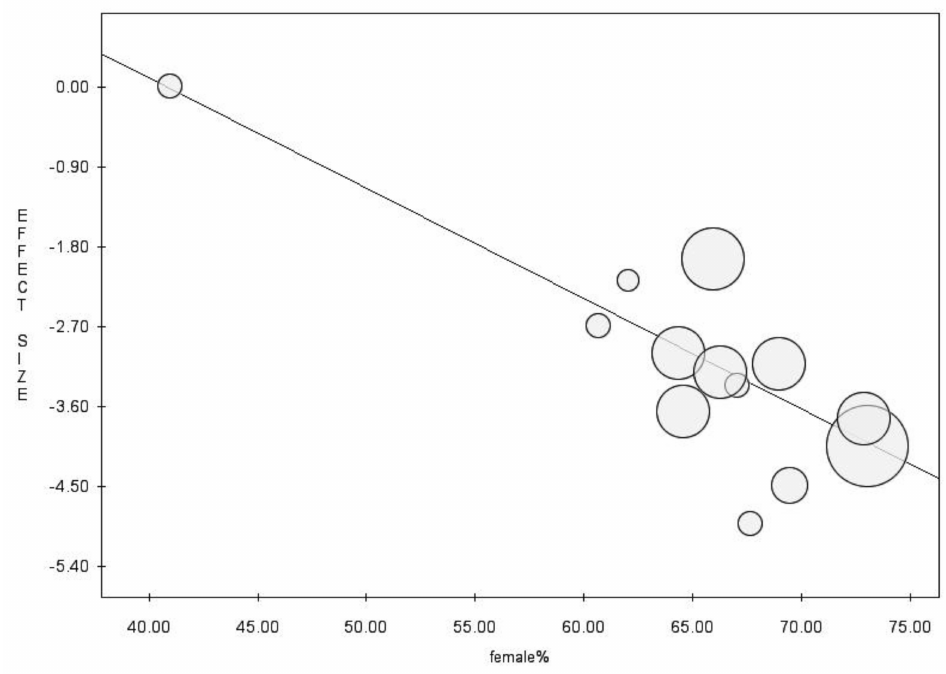
Figure 10. Meta-regression analysis for proportion of female gender, showing negative associations with the proportion of non-responding